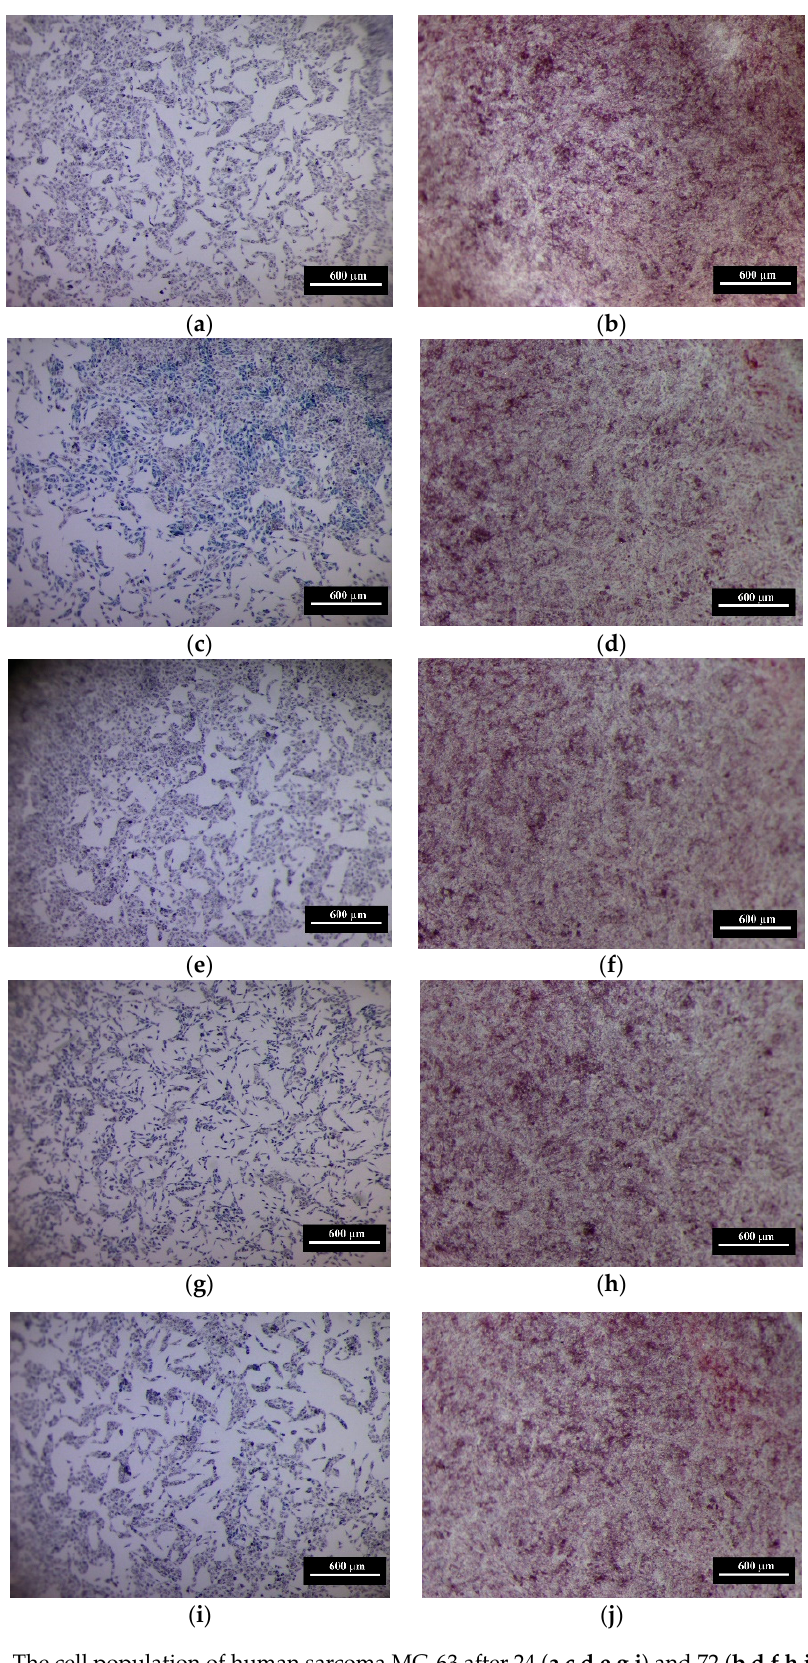
Figure 12. The cell population of human sarcoma MG-63 after 24 ( a , c , d , e , g , i ) and 72 ( b , d , f , h , j ) hours of CGM (control, a , b ) and in the presence of extracts of composite ceramic samples with 0.0 ( c , d ), 0.33 ( e , f ), 1.0 ( h , g ) and 3.0 ( i , j ) mol% Co, respectively .